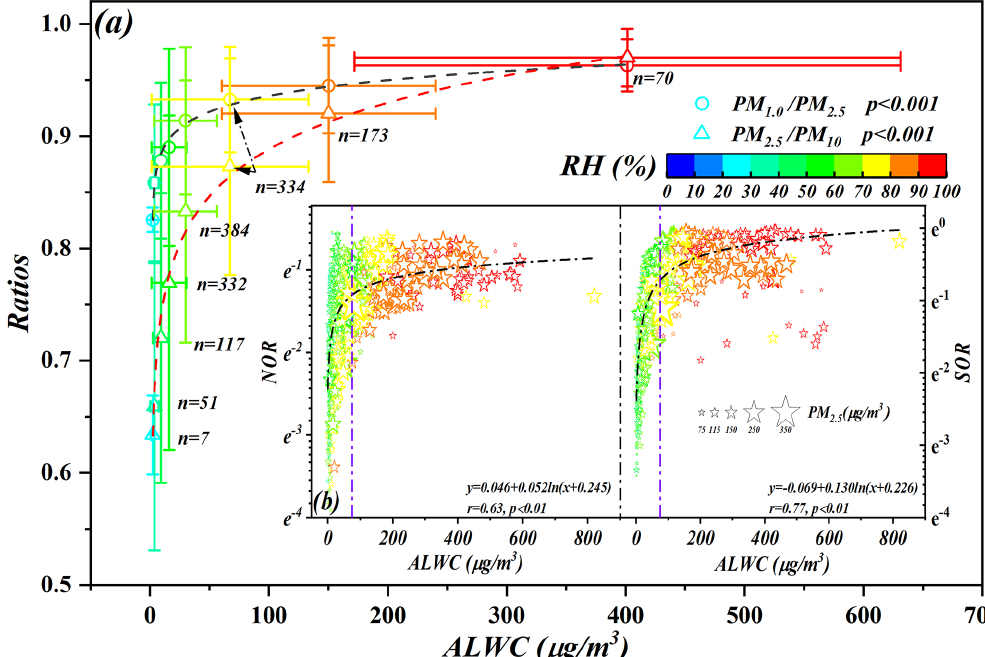
Figure 3. (a) Correlations between ALWC and ratios of PM response to relative humidity evolutions; (b) correlations between ALWC and NOR and SOR in their response to different pollution stages; the pentagrams are colored as a function of relative